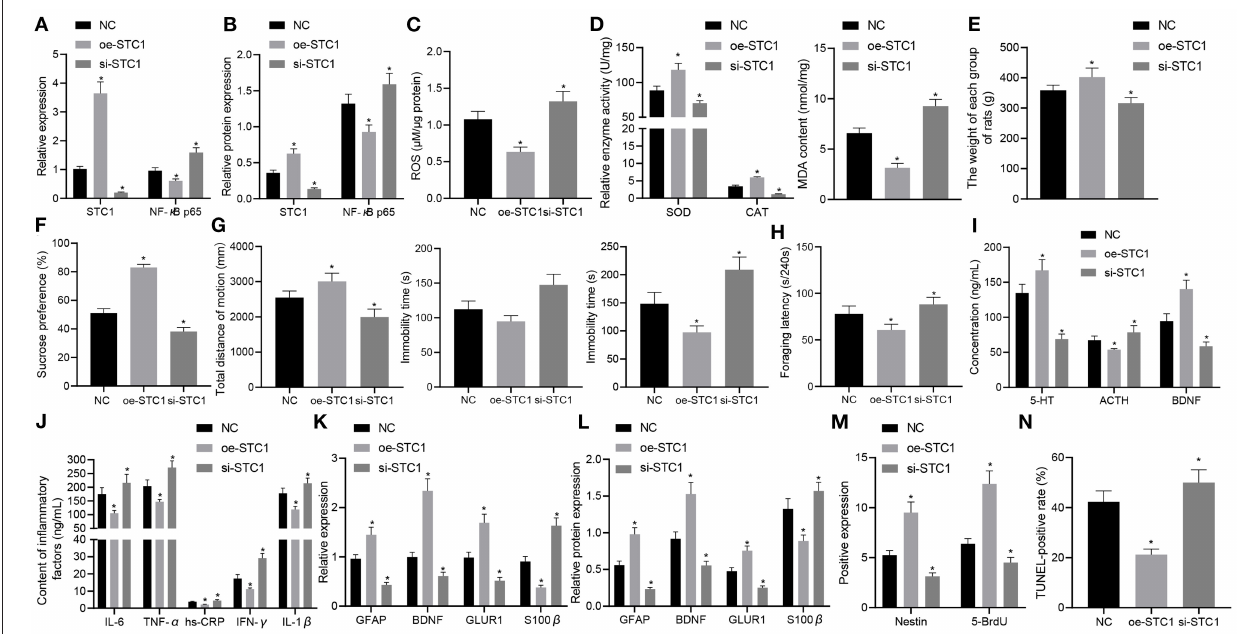
FIGURE 6 | STC1 overexpression reduces depression-like behaviors. (A) STC1 and NF- κ B p65 mRNA expression in the hippocampal tissues of rats with depression-like behaviors determined by RT-qPCR. (B) STC1 and NF- κ B p65 protein expression in the hippocampal tissues of rats with depression-like behaviors measured by Western blot assay. (C) ROS production in the hippocampal tissues of rats with depression-like behaviors. (D) SOD, CAT, and MDA levels in the hippocampal tissues of rats with depression-like behaviors. (E) weight of rats with depression-like behaviors. (F) sucrose preference in rats with depression-like behaviors. (G) total movement distance and cumulative immobility time of rats with depression-like behaviors in the forced-swimming test and tail suspension experiment. (H) latency time of food foraging of rats with depression-like behaviors. (I) 5-HT, BDNF, and ACTH levels in the serum of rats with depression-like behaviors. (J) IL-1 β , IL-6, TNF- α , hs-CRP, and IFN- γ levels in serum of rats with depression-like behaviors. (K) expression of neural plasticity-related genes (BDNF, GIUR1 and GFAP) and S100 β determined by RT-qPCR. (L) expression of neural plasticity-related proteins (BDNF, GIUR1 and GFAP) and S100 β measured by